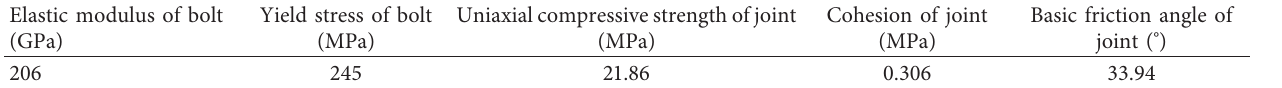
Table 1: Mechanical parameters of sample and